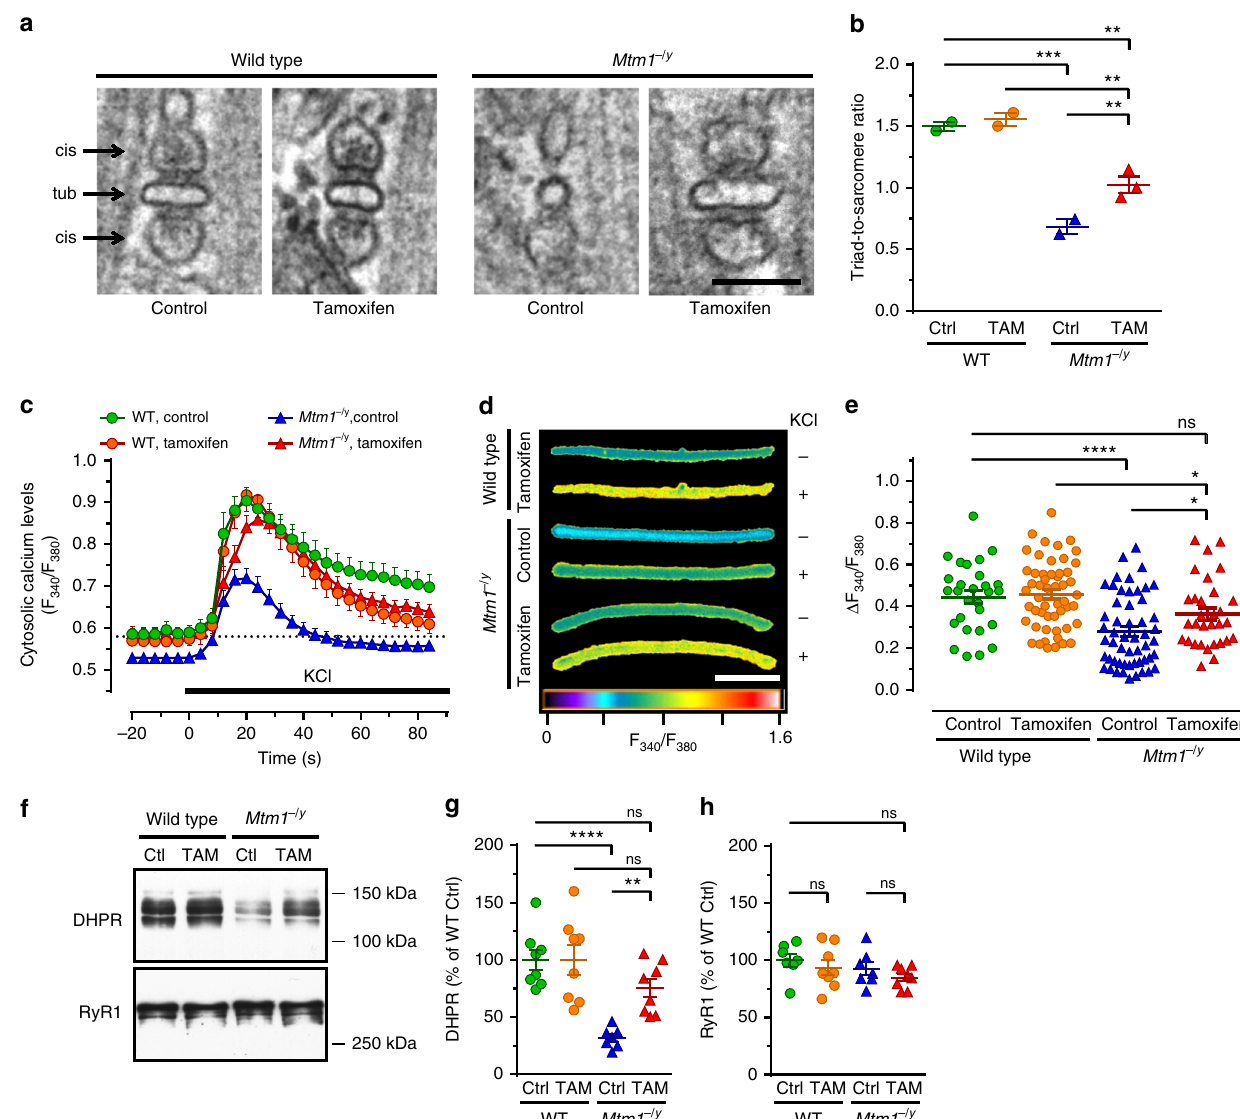
Fig. 5 Tamoxifen improves triad density and excitation-contraction coupling, Triads and excitation – contraction coupling were examined in 42 days old (D42) mice either untreated (control; Ctrl) or treated with tamoxifen (TAM; 30 mg kg − 1 in diet). a Triads — specialized membrane structures made of a t- tubule (tub) fl anked by terminal cisternae ( cis ) arising from the sarcoplasmic reticulum and controlling Ca 2 + release — were visualized by transmission electron microscopy (TEM) in the tibialis anterior (TA) of mice at D42. Note the abnormal shape of the remaining triads in the Mtm1 − /y mouse and recovery with tamoxifen treatment. The bar represents 100 nm. b The number of well-positioned triads per sarcomere unit was determined from TEM pictures in TA from wild type (WT) and Mtm1 − /y mice at D42. TAM partly rescued the much decreased triad density in Mtm1 − /y mice. Mean ± s.e.m. of n = 2 – 3 mice. c – e Excitation – contraction coupling assessed via live imaging of Ca 2 + fl uxes induced by KCl depolarization in single FDB myo fi bers (see Online Methods for details). c Average traces of the responses of FDB fi bers to KCl, an experimental setting that mimics muscle depolarization ( n = 17 – 29 fi bers). d Representative images (pseudo-colored) illustrating cytosolic Ca 2 + levels in FDB fi bers at baseline ( − ; before KCl pulse) and at the peak of KCl-induced response ( + ). The bar represents 100 μ m. e Quanti fi cation of cytosolic Ca 2 + at the peak response. TAM enhanced Mtm1 − /y cytosolic Ca 2 + to levels found in WT. Data shown in e represent, from left to right, the mean ± s.e.m. of n = 29, 53, 53, and 31 fi bers. f Representative western blots of DHPR and RyR1. g , h Quanti fi cation of DHPR and RyR1, respectively. Mean ± s.e.m. of n = 7 muscles. * P ≤ 0.05; ** P ≤ 0.01; *** P ≤ 0.001; **** P ≤ 0.0001; ns non-signi fi cant. One-way ANOVA followed by Fisher ’ s LSD breeding wild type males with Mtm1 + / − heterozygous females. The Mtm1 + /y (wild type) and Mtm1 − /y (mutant) males in the progeny were used in experiments. Mice were housed on wood granule bedding in either Eurostandard type II or type III polycarbonate cages equipped with fi lter tops (Indulab AG, Gams, Switzerland). They were kept on a 12-h dark/12-h light cycle, under constant temperature (22 ± 1°C) and humidity (50 – 60%). Mice were allowed unlimited access to food and water throughout the study. Environment enrichment consisted in a Mouse House (Indulab AG), shredded paper, and cylinders of pure cellulose (Cocoon, Datesand, Manchester, UK).